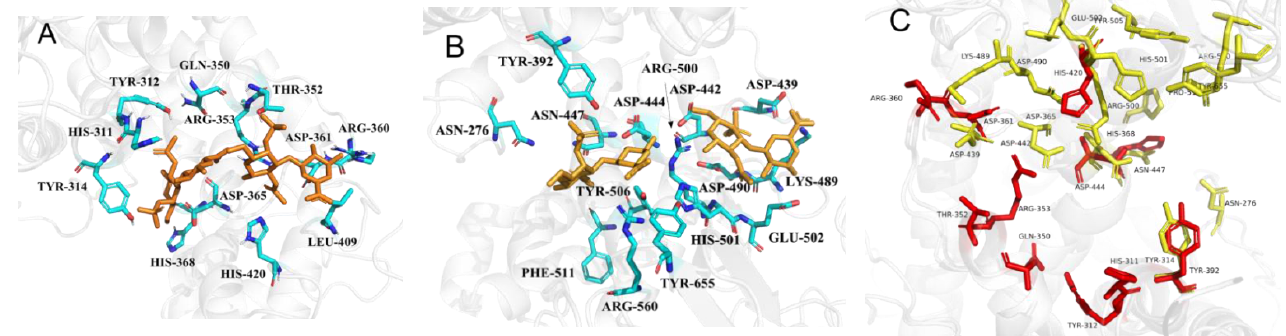
Figure 8. Visualization of molecular docking of the Chon-ABC and CS. The Chon-ABC and CS ( A ), the pv -cABC ( B ), and the superimposition of the Chon-ABC and pv -cABC ( C ). Molecular docking was performed with AutoDock4 (Lamarckian genetic algorithm, number of runs